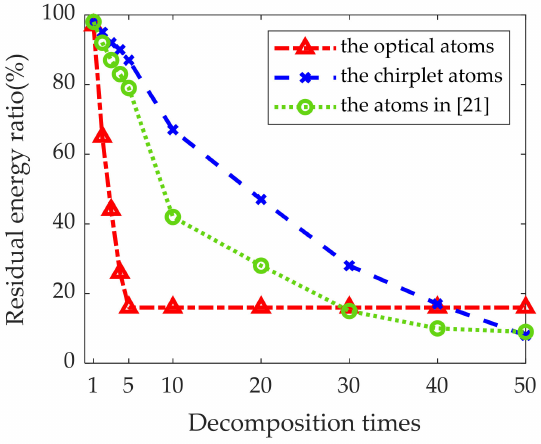
Figure 8. Variation curves of residual energy ratio after decomposition with different atomic dictionaries.